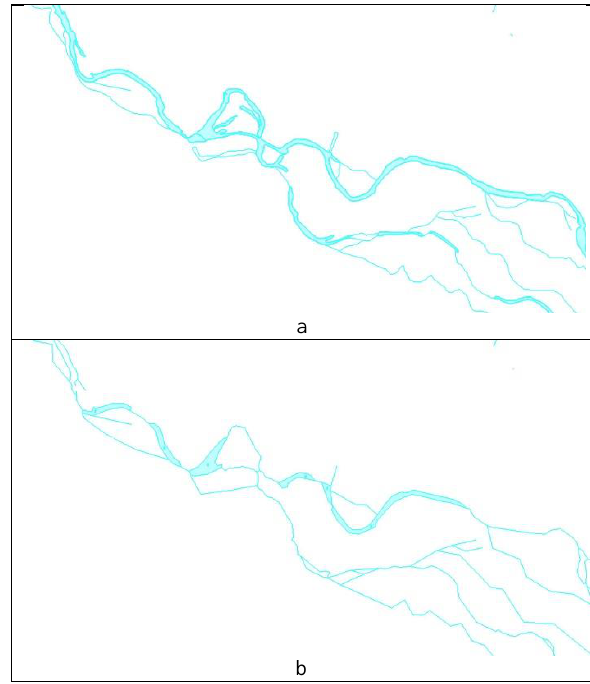
Figure 5. a: the river in base map is shown by polygon, b: the river convert to polyline in generalized